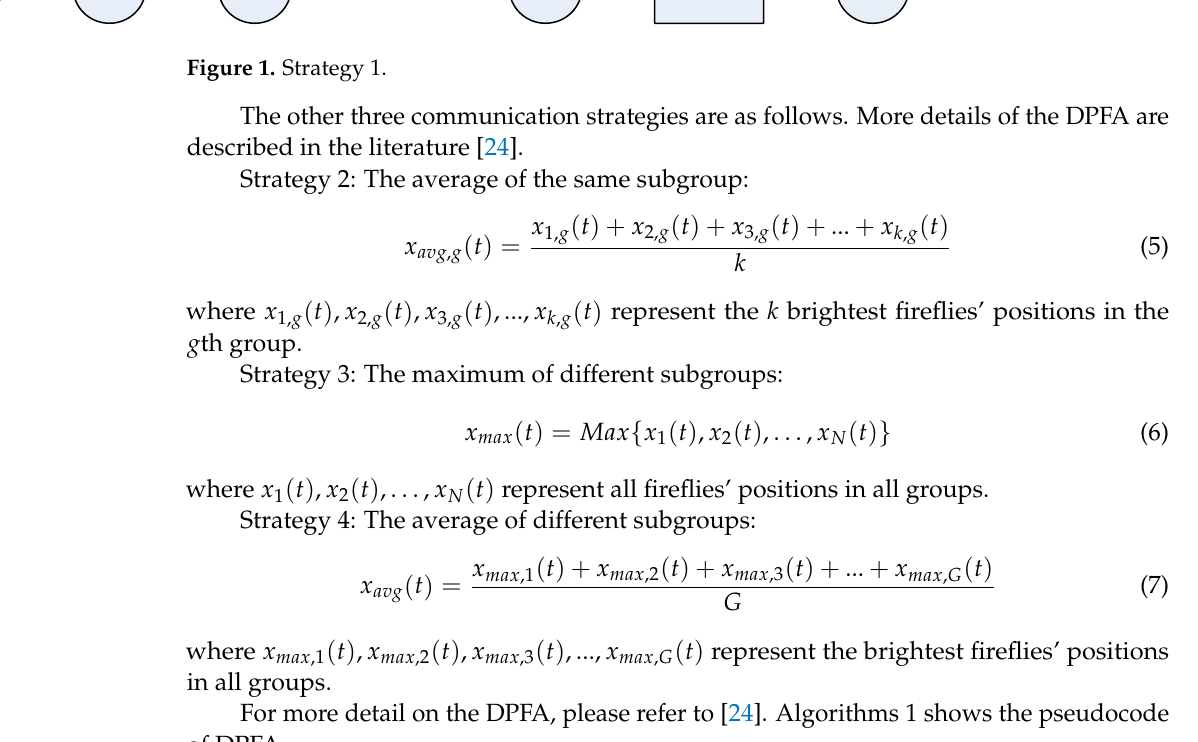
Figure 3. The new communication strategy 2.